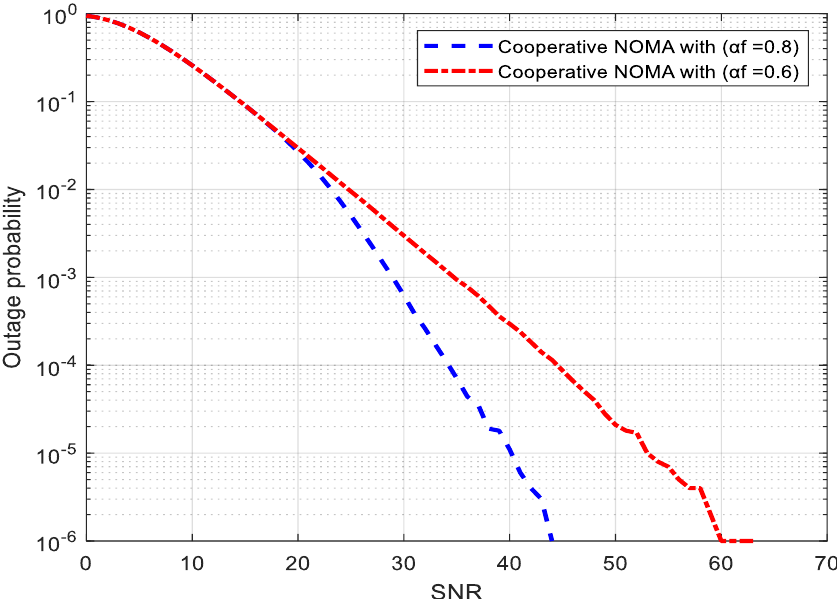
Figure 5. Outage probability against SNR for the two far users’ DL cooperative NOMA PD.